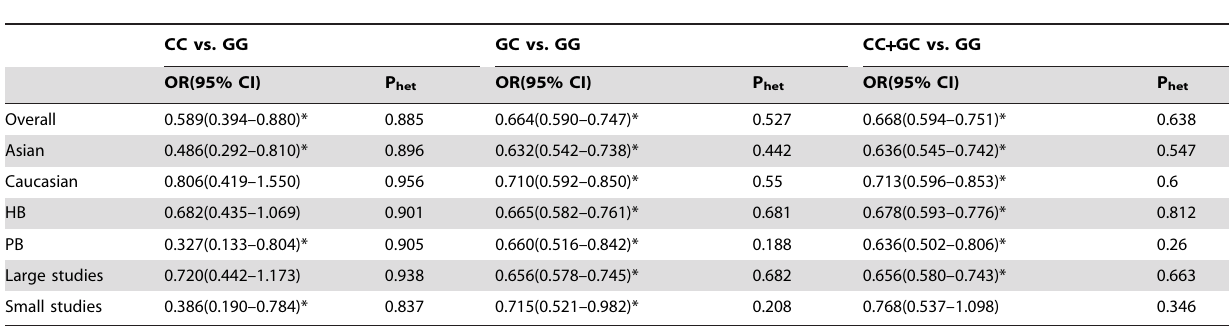
Table 3. Meta-analysis results estimated by adjusted odds